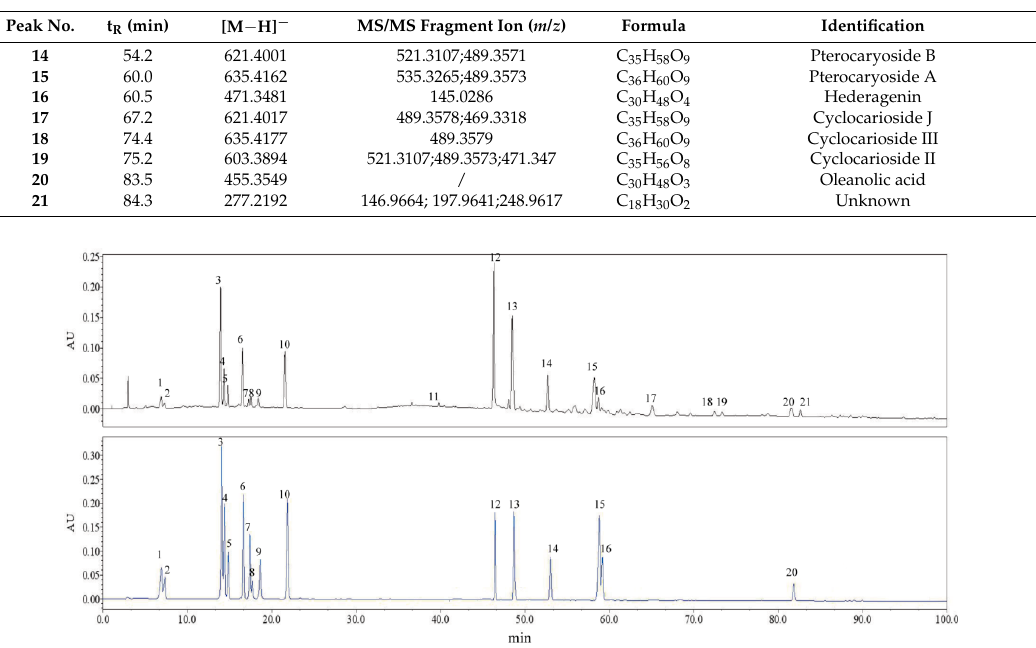
Figure 3. HPLC chromatograms of a representative sample solution ( top ) and a mixed standard solution containing the 16 quantitative compounds ( bottom ).